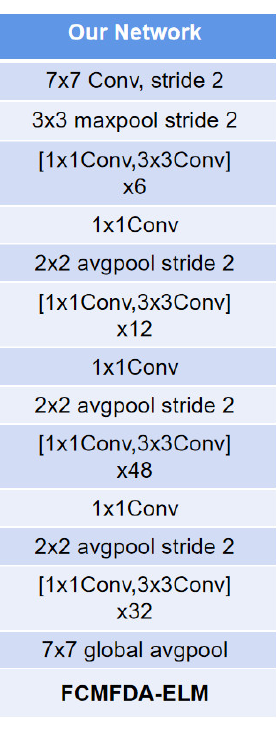
Figure 4. Flow chart of underwater image classification algorithm based on convolution network and ELM optimized by FCMFDA.